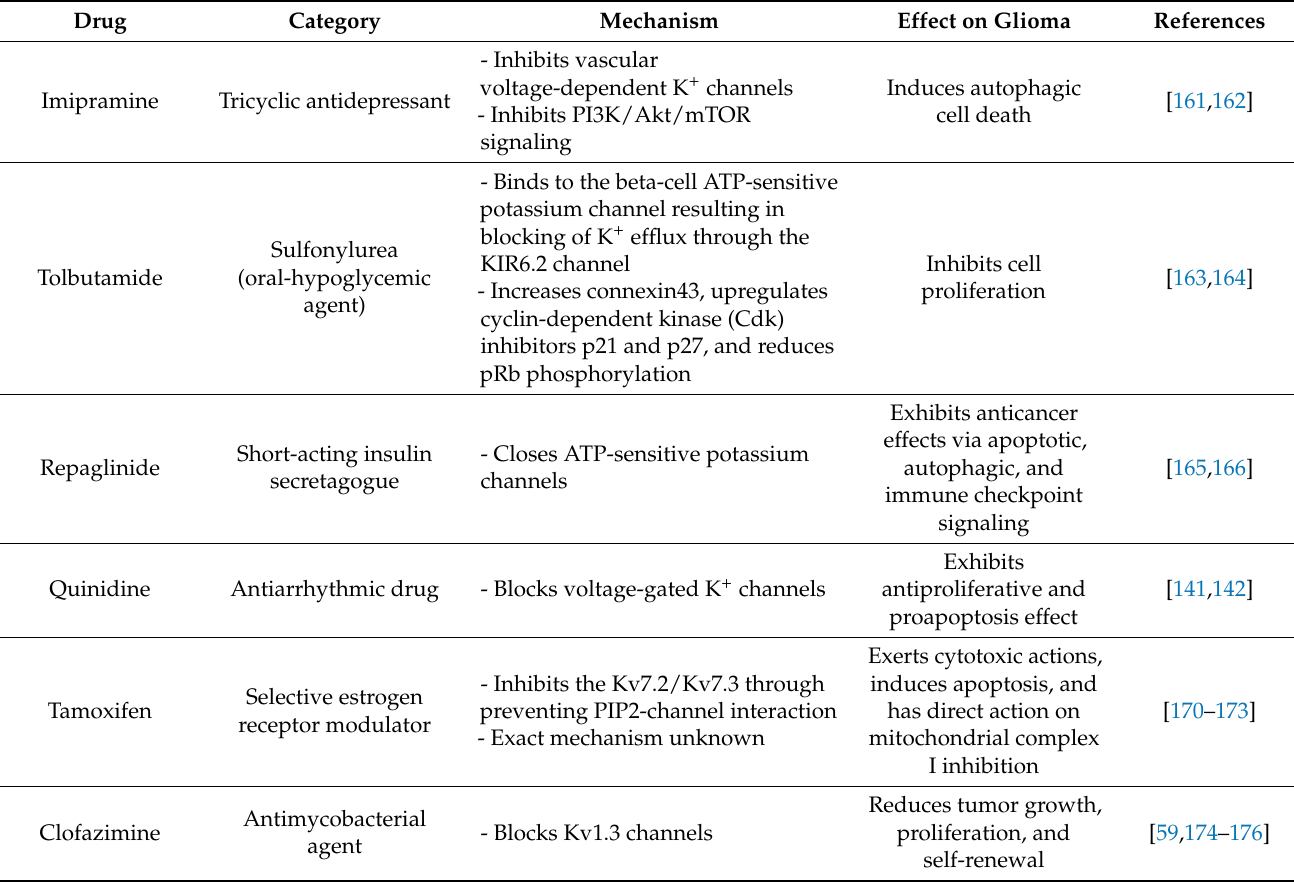
Table 2. Approved drugs that are candidates for drug repurposing for glioma